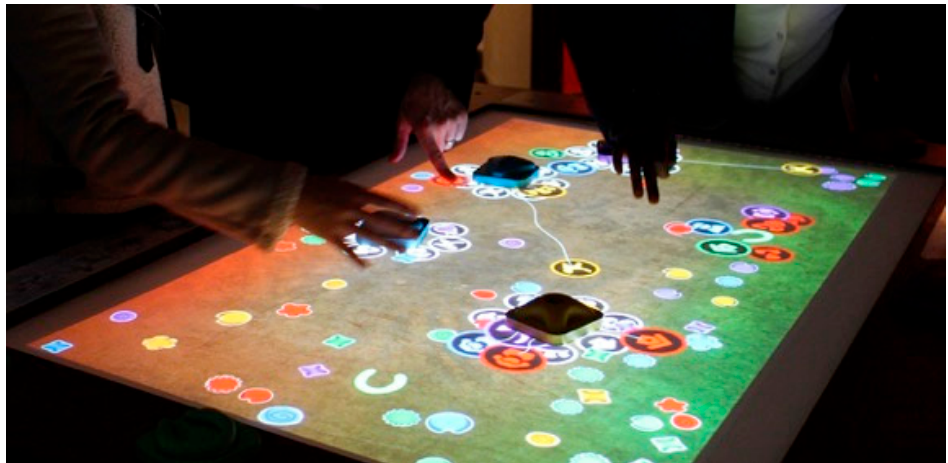
Figure 6. Interaction around the tabletop in the Mapping Place exhibition.